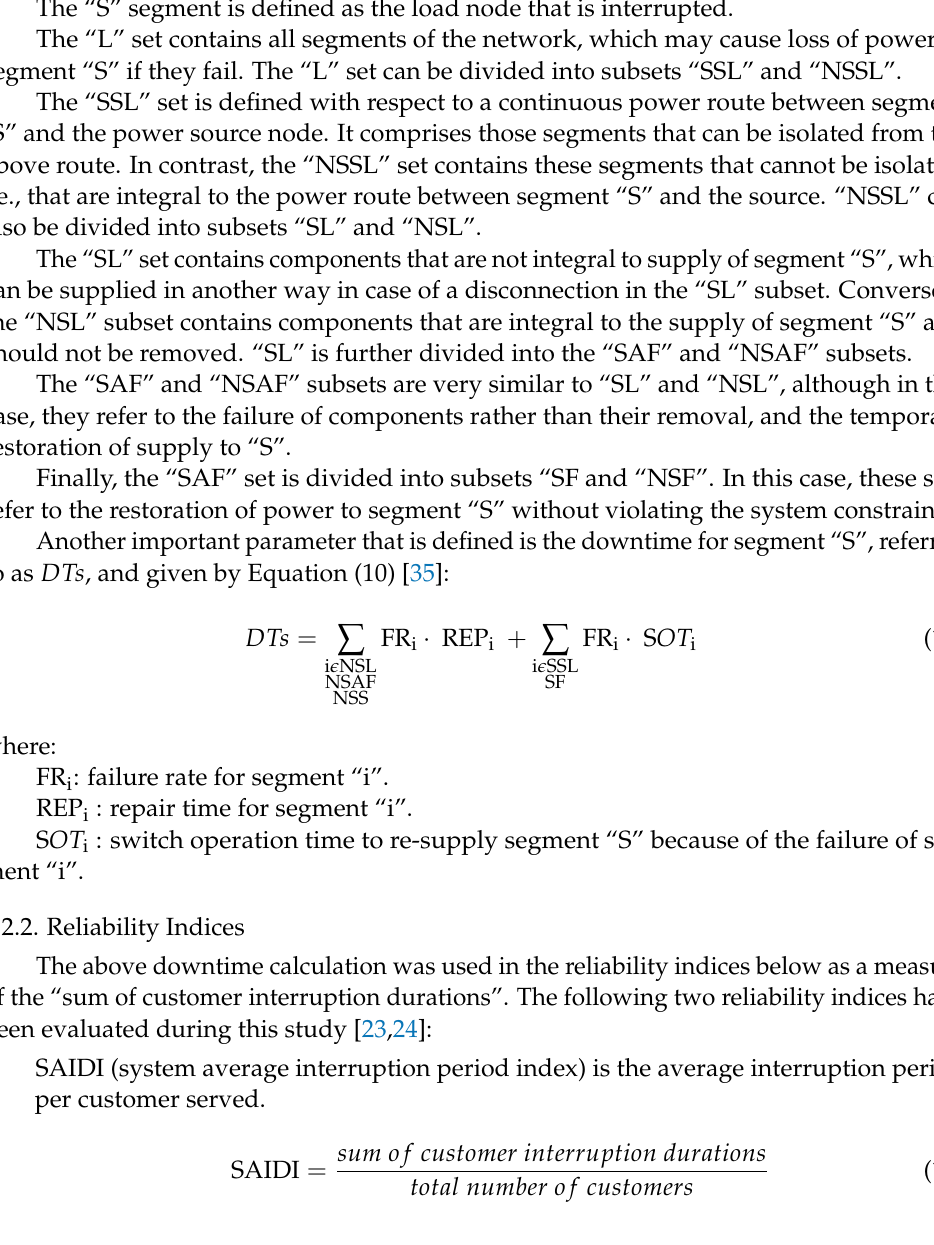
Figure 7. Reliability analysis sets as described in [29].